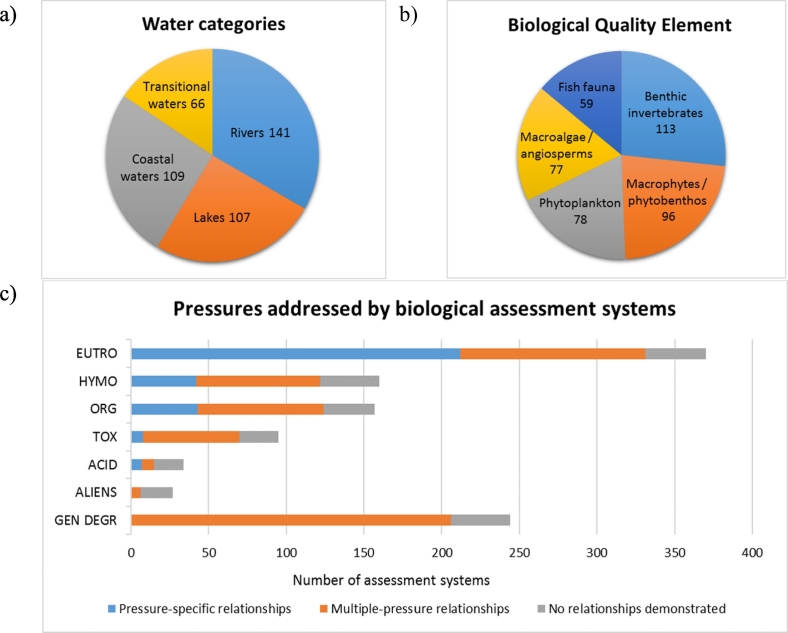
Overview of aquatic assessment methods for the Water Framework Directive (WFD); a) water categories; b) biological quality elements (BQE); c) pressures assessed and relationships demonstrated. EUTRO: eutrophication; HYMO: hydromorphology; ORG POLL: organic pollution; TOX: toxicity; ACID: acidification; GEN DEGR: general degradation.